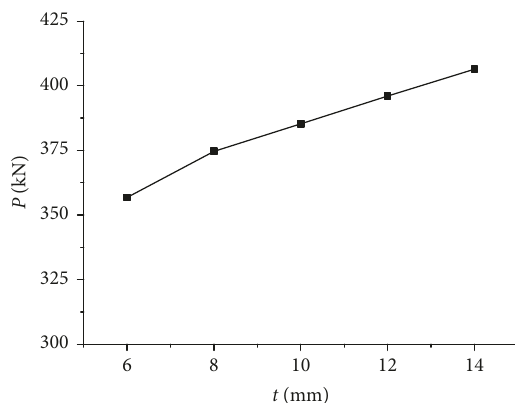
Figure 11: Relationship between steel plate thickness and shear capacity.